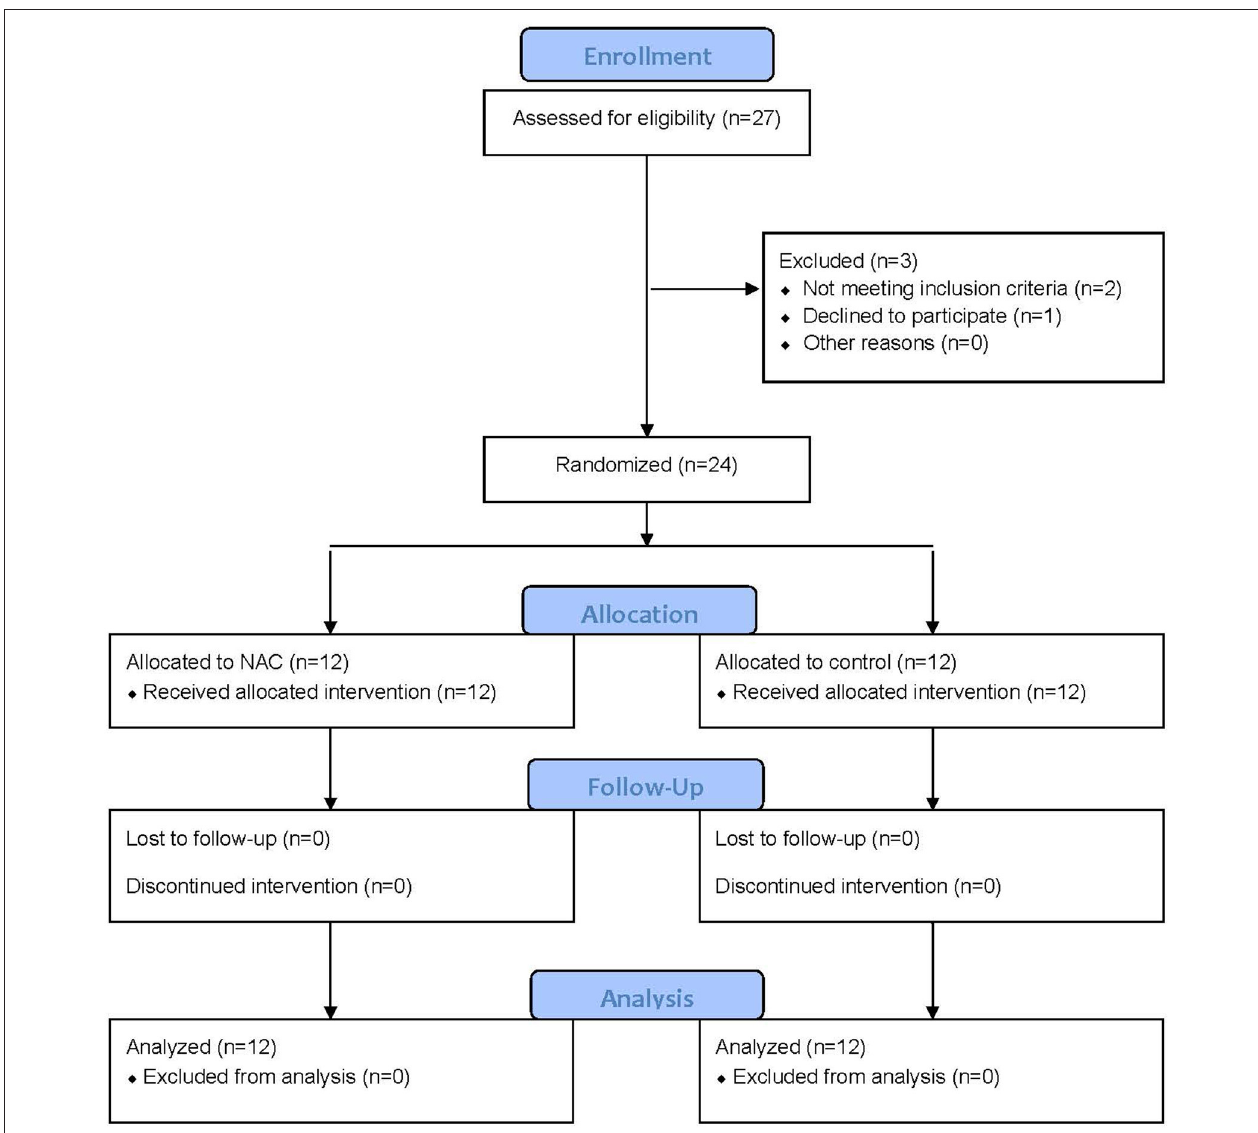
FIGURE 1 | CONSORT Flow Diagram for the study